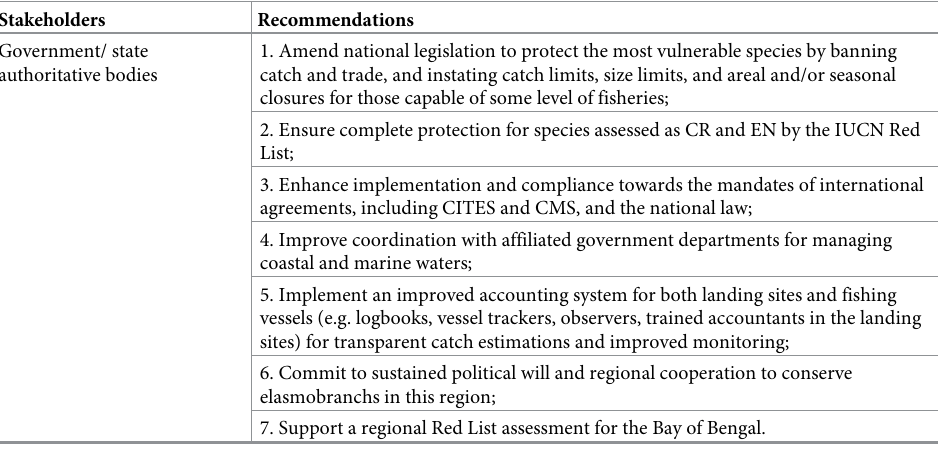
Table 3. Priority recommendations for elasmobranch research and conservation